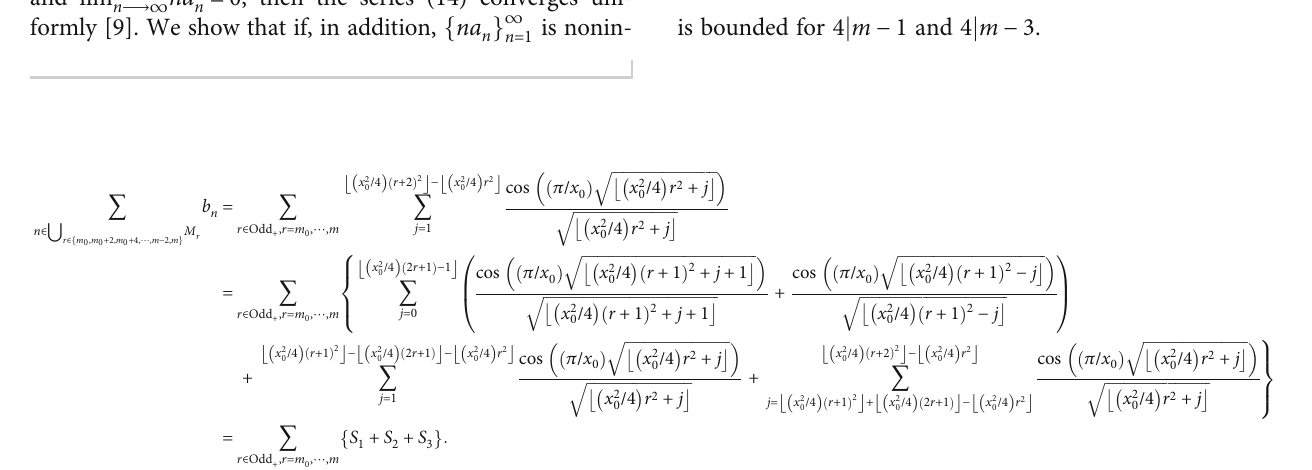
ffiffiffiffiffiffiffiffiffiffiffiffiffiffiffiffiffiffiffiffiffiffiffiffiffiffiffi (cid:3) x 2 /4 0 ffiffiffiffiffiffiffiffiffiffiffiffiffiffiffiffiffiffiffiffiffiffiffiffiffiffiffi x 2 /4 0